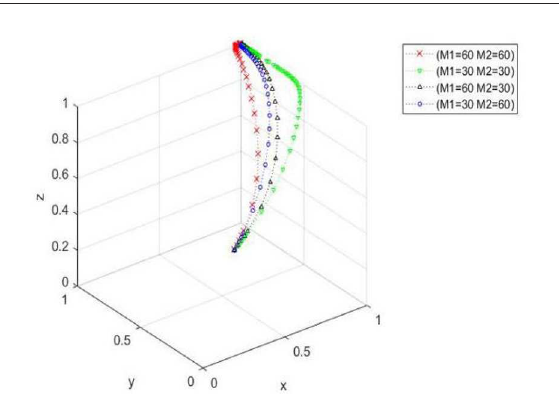
FIGURE2 Spatial diagram of the influence of the change of incentive and punishment on the evolutionary path of farmers given by